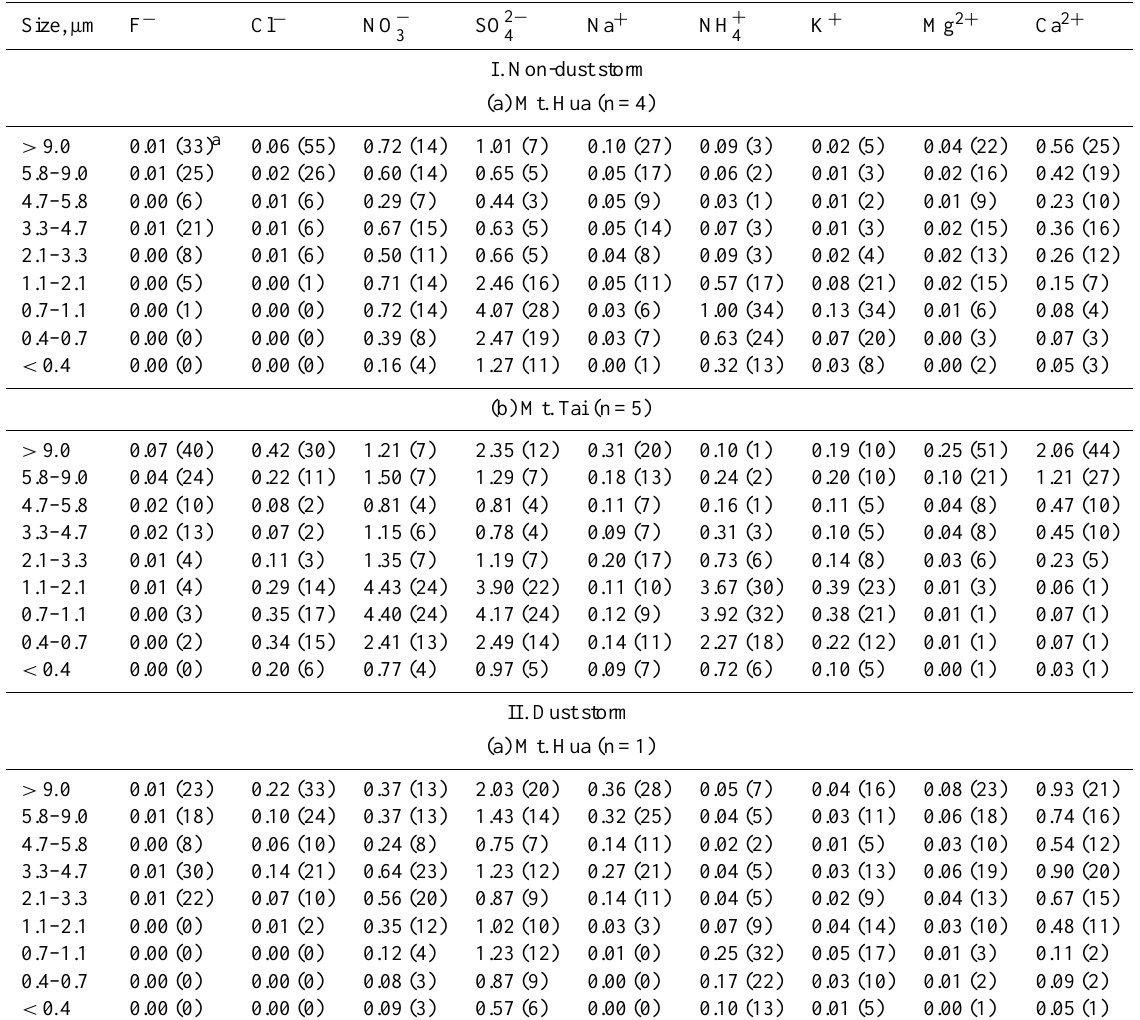
Table 6. Averaged concentration of inorganic ions in each stage at Mt. Hua and Mt. Tai during the non-dust storm and dust storm periods in spring 2009, µgm − 3